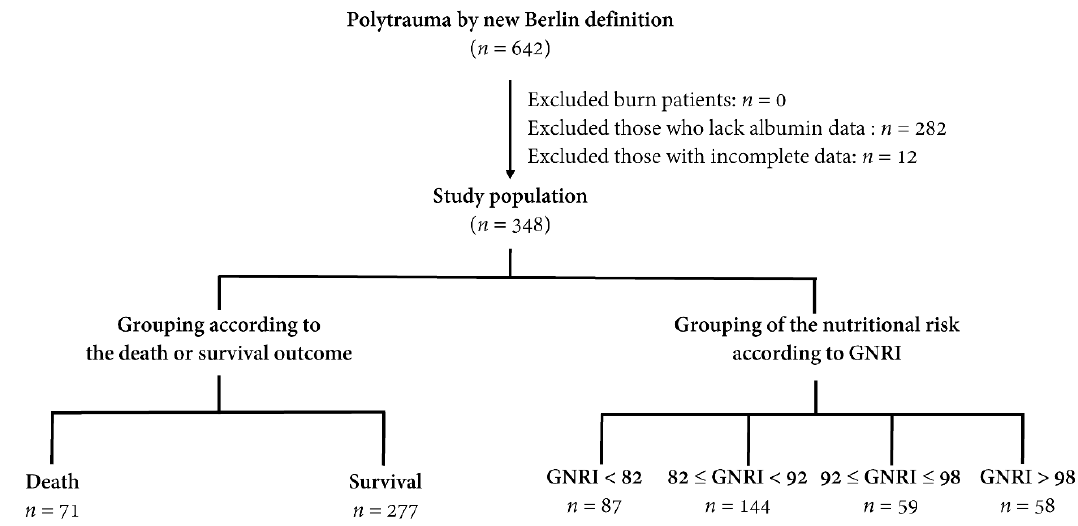
Figure 1. Flowchart illustrating the inclusion of adult patients with polytrauma from the Trauma Registry System, with the allocation of these patients into groups of death and survival as well as groups of four nutritional risk groups according to the geriatric nutritional risk index (GNRI).